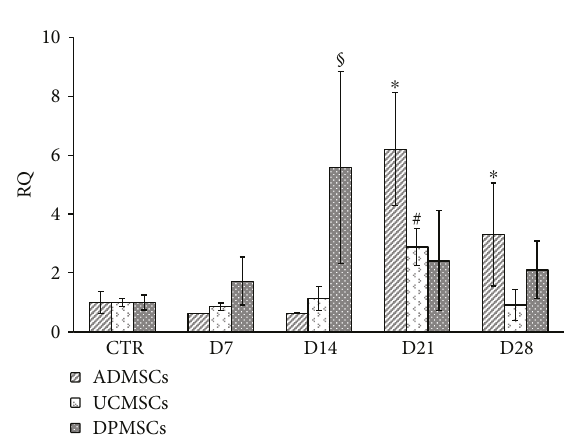
Figure 4: mRNA expression of COL10A in the ADMSCs, UCMSCs, and DPMSCs induced to chondrogenic di ff erentiation up to 28 days. The experiments were performed three times. Data were expressed as mean ± SD. ∗ p < 0 05 , as compared to control ADMSCs; § p < 0 05 , as compared to control DPMSCs. # p < 0 05 , as compared to control